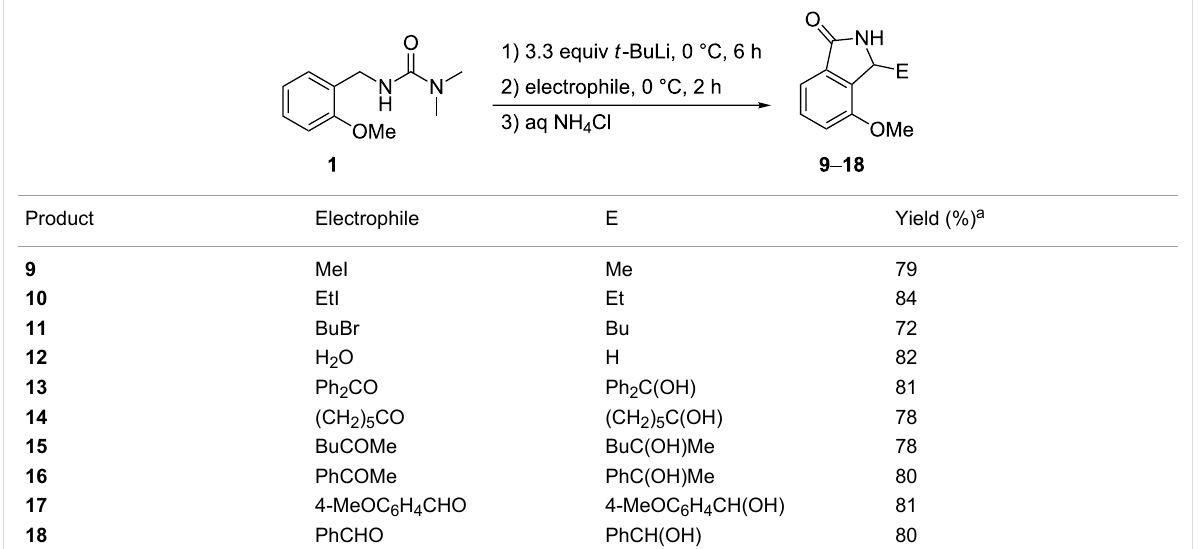
crystallized materials showed what appeared to be a single component in each case. The crystalline products were there- fore subjected to X-ray crystallography. The structures found are illustrated in Figure